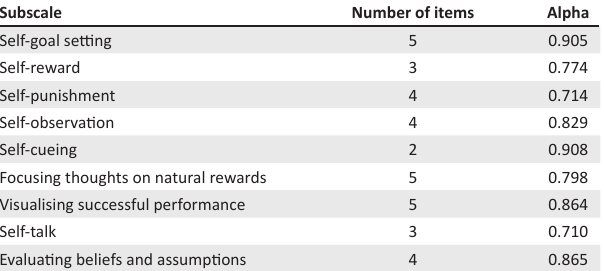
TABLE 4: Reliability estimates for the nine subscales (RSLQ, n = 405). Subscale